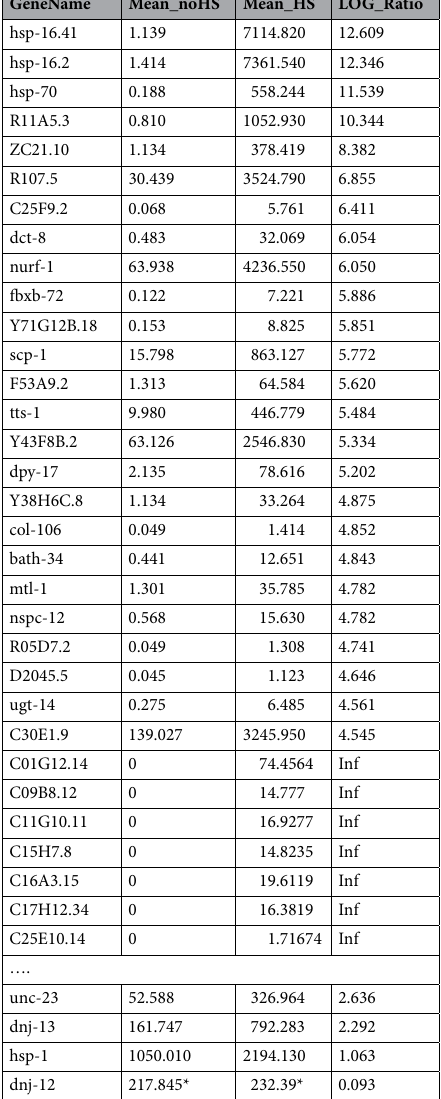
Table 4. Significantly enriched genes in the heat-shock experiments of Li et al. 17 . Individual induced genes are shown compared to their non-stressed state. *The gene dnj-12 was not included in the available final tables and therefore was calculated based on the raw data. The raw data values were divided by 40 to achieve a similar level of normalization as for the other genes. Raw data mean prior to normalization for all genes is 80 versus 83, thus substantially lower compared to the values of 8713.66 and 9295.77 found for dnj-12 prior to